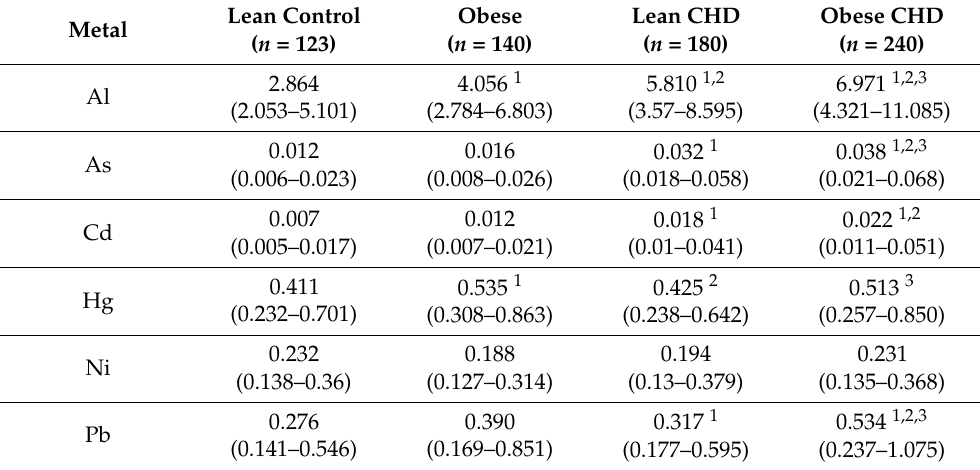
Table 2. Hair toxic metal content ( µ g/g) in normal-weight and obese patients with coronary heart disease and healthy